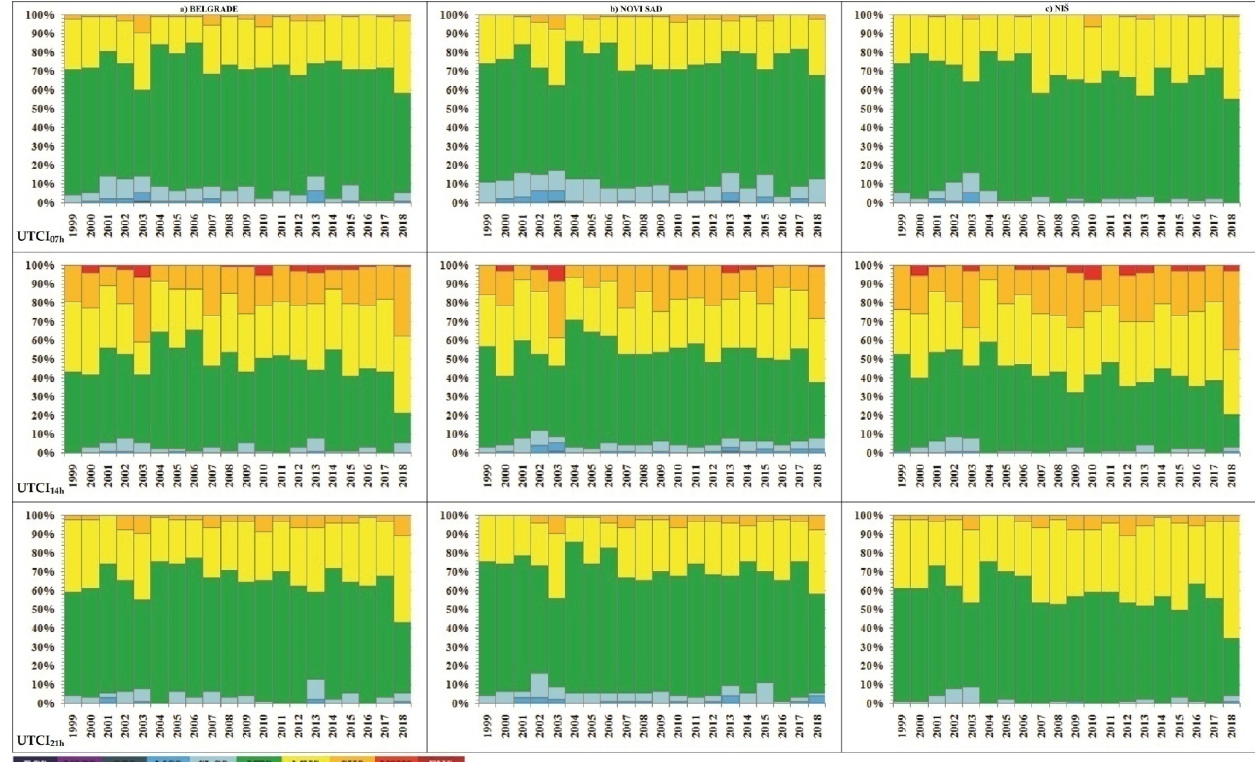
Figure 2. Frequencies of different cold and heat stress category in ( a ) Belgrade; ( b ) Novi Sad, and ( c ) Niš based on UTCI 07h (first column), UTCI 14h (second column), UTCI 21h (third column) during spring, over a period of 20 years (1999–2018).